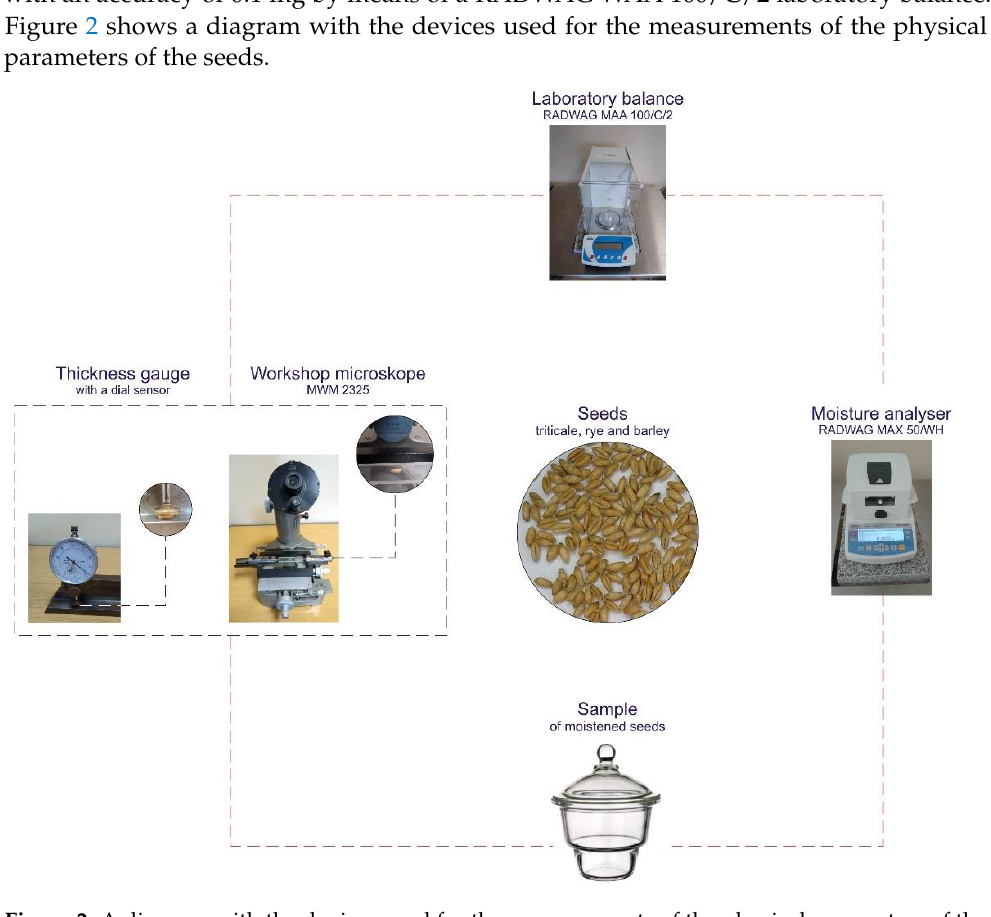
Figure 2. A diagram with the devices used for the measurements of the physical parameters of the seeds used in the experiment, depending on their moisture